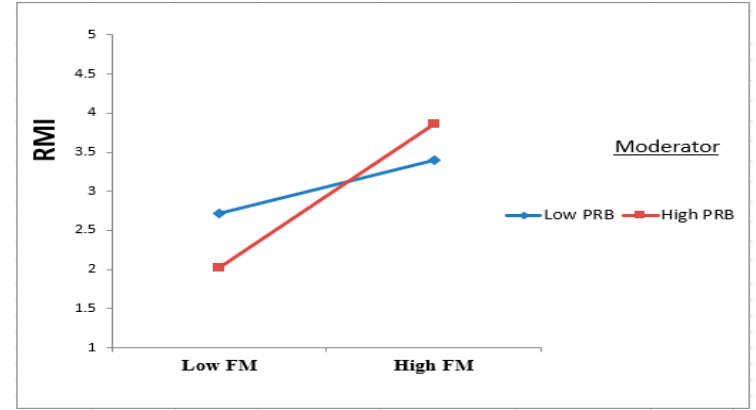
Figure 4. Interaction plot for the PRB moderation effect on FM towards RMI.